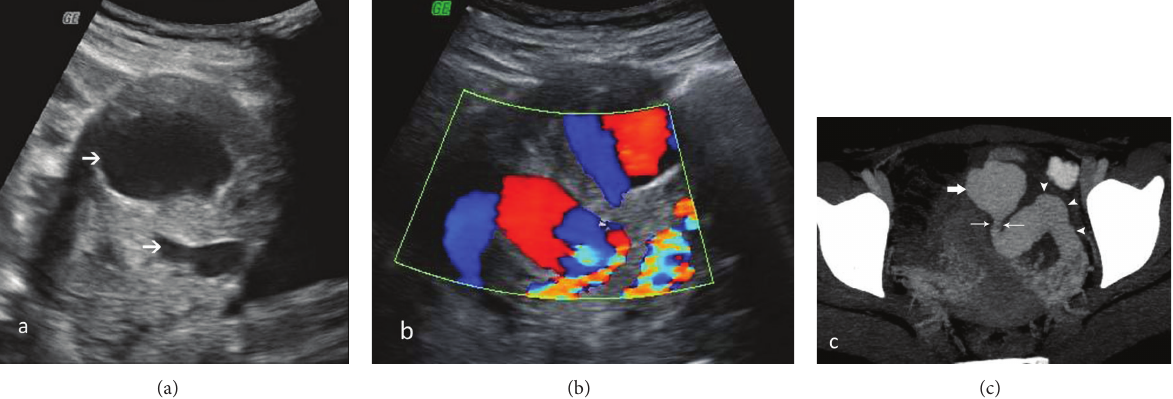
Figure 6: A 25-year-old patient presenting with episodic torrential vaginal bleeding, 3 months after completion of chemotherapy for choriocarcinoma. 𝛽 -hCG levels were not raised. Grey-scale TAS (a) shows two large anechoic lesions in the myometrium (arrows). Color Doppler (b) demonstrates a whirled to-and-fro color flow in these cystic spaces. CT angiogram image (c) reveals a grossly dilated left uterine artery (arrowheads) with a saccular pseudoaneurysm (thick arrow) showing a narrow neck (thin arrows) arising from it and protruding into the adjoining